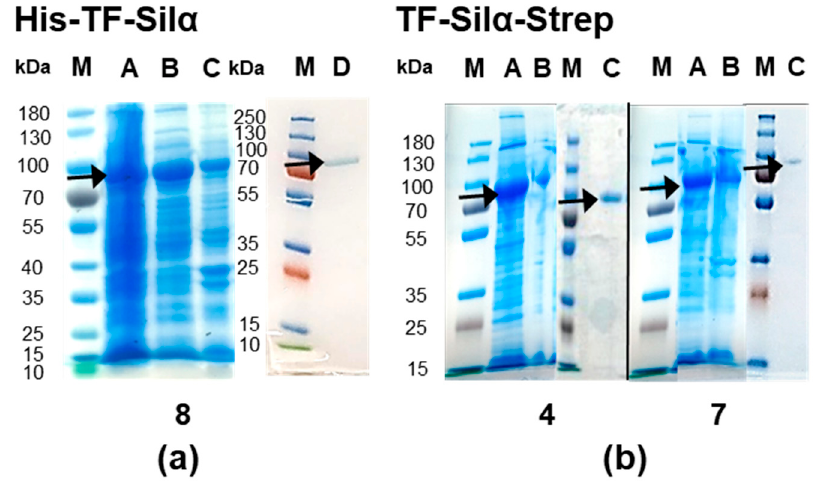
Figure 2. Images of SDS-PAGE gels demonstrating solubility analysis for ( a ) His 6 -TF-Sil α ; and ( b ) TF-Sil α -Strep. For ( a ), the bu ff er stated in entry 8 of Table 1 was used; for ( b ), the bu ff er mixtures stated in Table 2 were used (numbers below each image correspond to the bu ff er entries in Table 2). Lanes for ( a ) are labelled as follows: M = marker, A = total lysed protein, B = soluble lysis fraction, C = insoluble lysis fraction, D = post-IMAC fraction. Lanes for ( b ) are labelled as: M = marker, A = soluble lysis fraction, B = insoluble lysis fraction, C = post-SAC fraction. Arrows are shown to indicate the presence of the desired protein band.